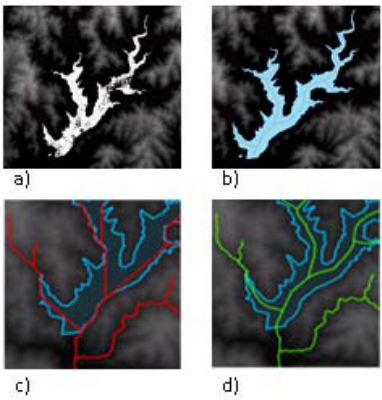
Figure 6. Surface hydrological modelling of water bodies: a) original DTM obtained from LiDAR data, b) water bodie and ficticious river network from cartography, c) automatic feature extracción witout modelling only filling gaps, d) automatic feature extraction with surface hydrological modelling Figure 7 resumes the procedure: get the DTM information out of the water body (PointElevation) using a exterior buffer from the cartographic water body, and together with the fictitious axe and elevation of points of the axe (Stream&PointElevation), those point are incorporated to the hydrologic interpolation to model the DTM. To determine the elevation points from the fictitious axe, minimum and maximum elevation are obtained, and then the rest of the nodes are interpolate over the axe, with a constant decreasing parameter, to force interpolation within the axe. Dams is also integrated, to help the modeling exercise. This process is done using the ArGIS TopoToRaster tool based on ANUDTM (Hutchinson, 2011)), which is a interpolation method specifically designed for creating hydrological DTM.